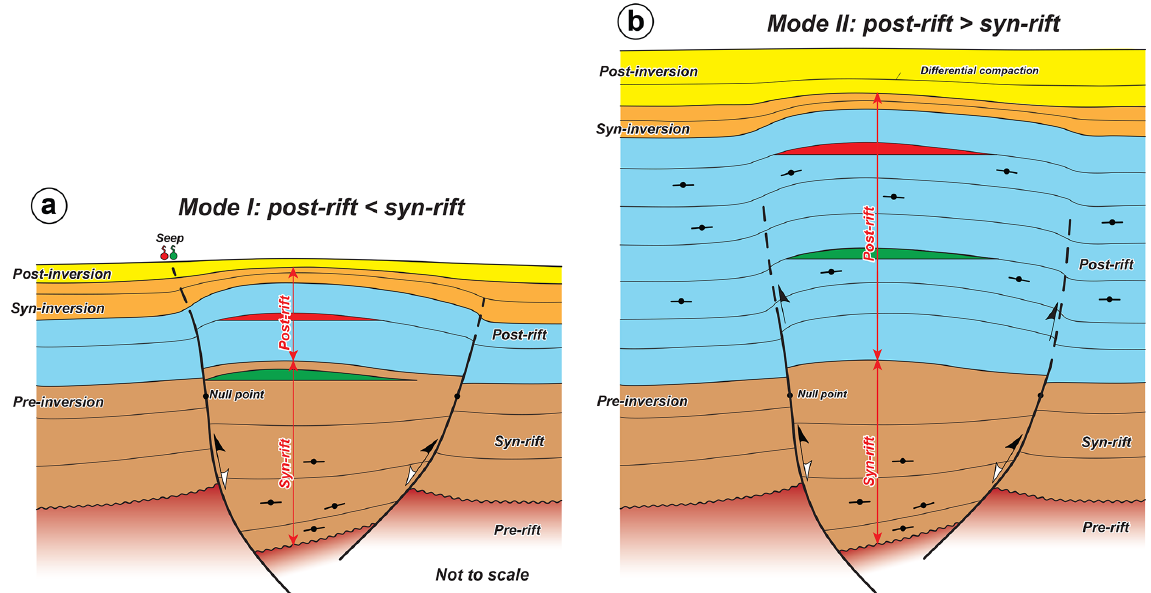
Figure 17. Subdivision of inversion structures into two modes of inversion. A structure develops in Mode I inversion if the syn-rift succession in the preexisting extensional basin unit is thicker than its pre- and syn-inversion parts of its post-rift cover. In contrast, a structure evolves in Mode II inversion if the opposite syn- versus post-rift (pre- and syn-inversion) sequence thickness ratio can be observed. These two modes have different impacts on the petroleum system elements in any given inversion